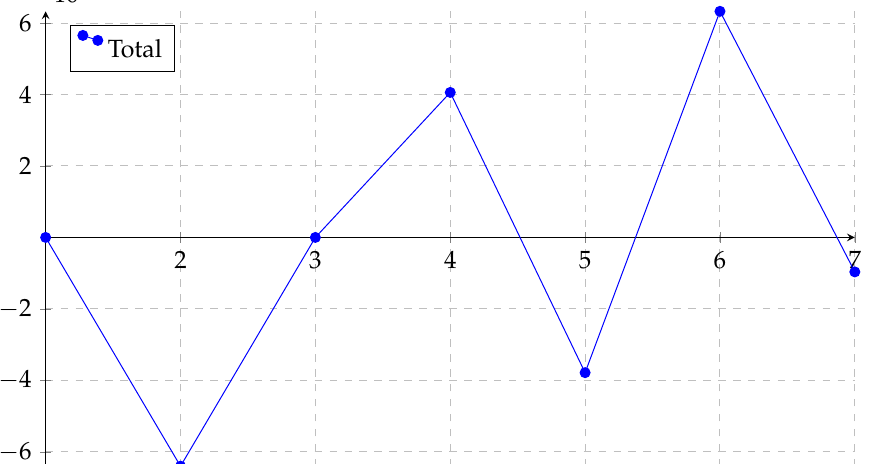
Figure 6. Differences in the amounts of financial compensation for four sets of substations.